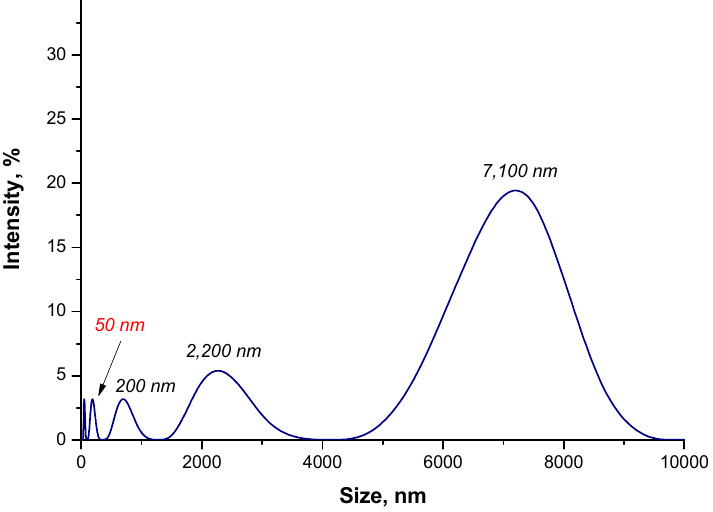
Figure 5. The size analysis of Fe 3 O 4 @Au particles obtained in the water environment.